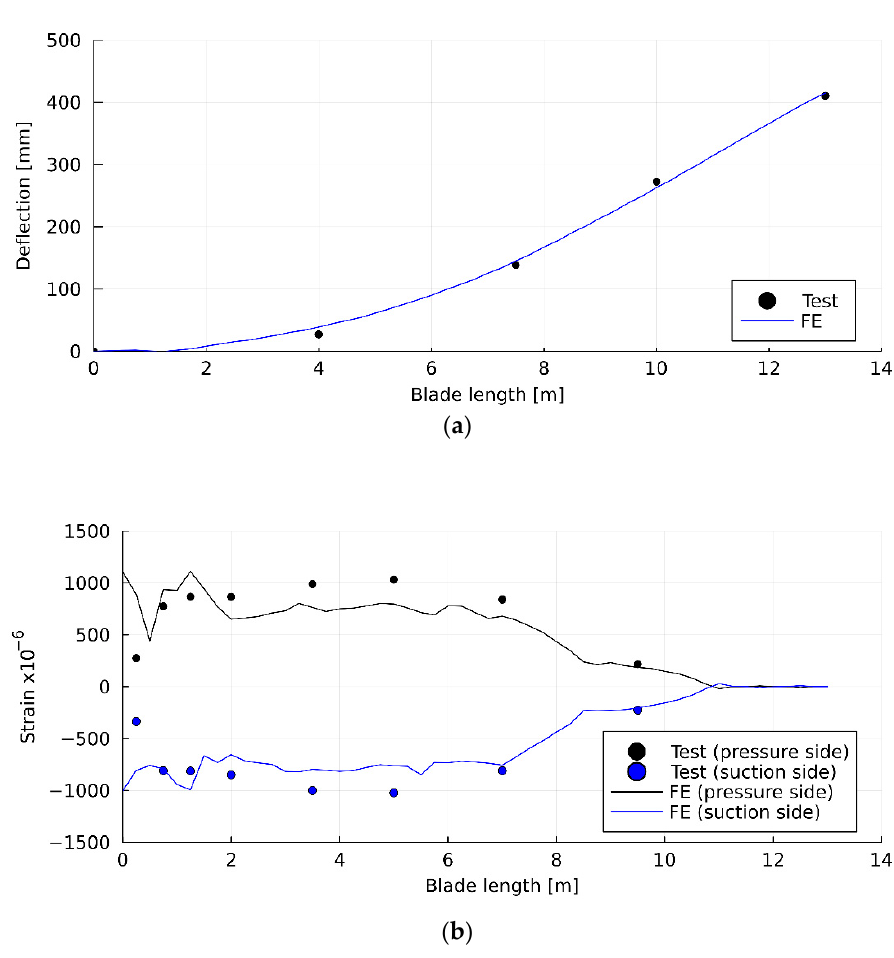
Figure 9. Validation of the FE model: ( a ) comparison of the blade deflection; ( b ) comparison of the spar cap strain distribution (under flapwise static loading, 100% load case). Table 7. Mechanical properties of the glass UD and carbon UD materials used in the study.